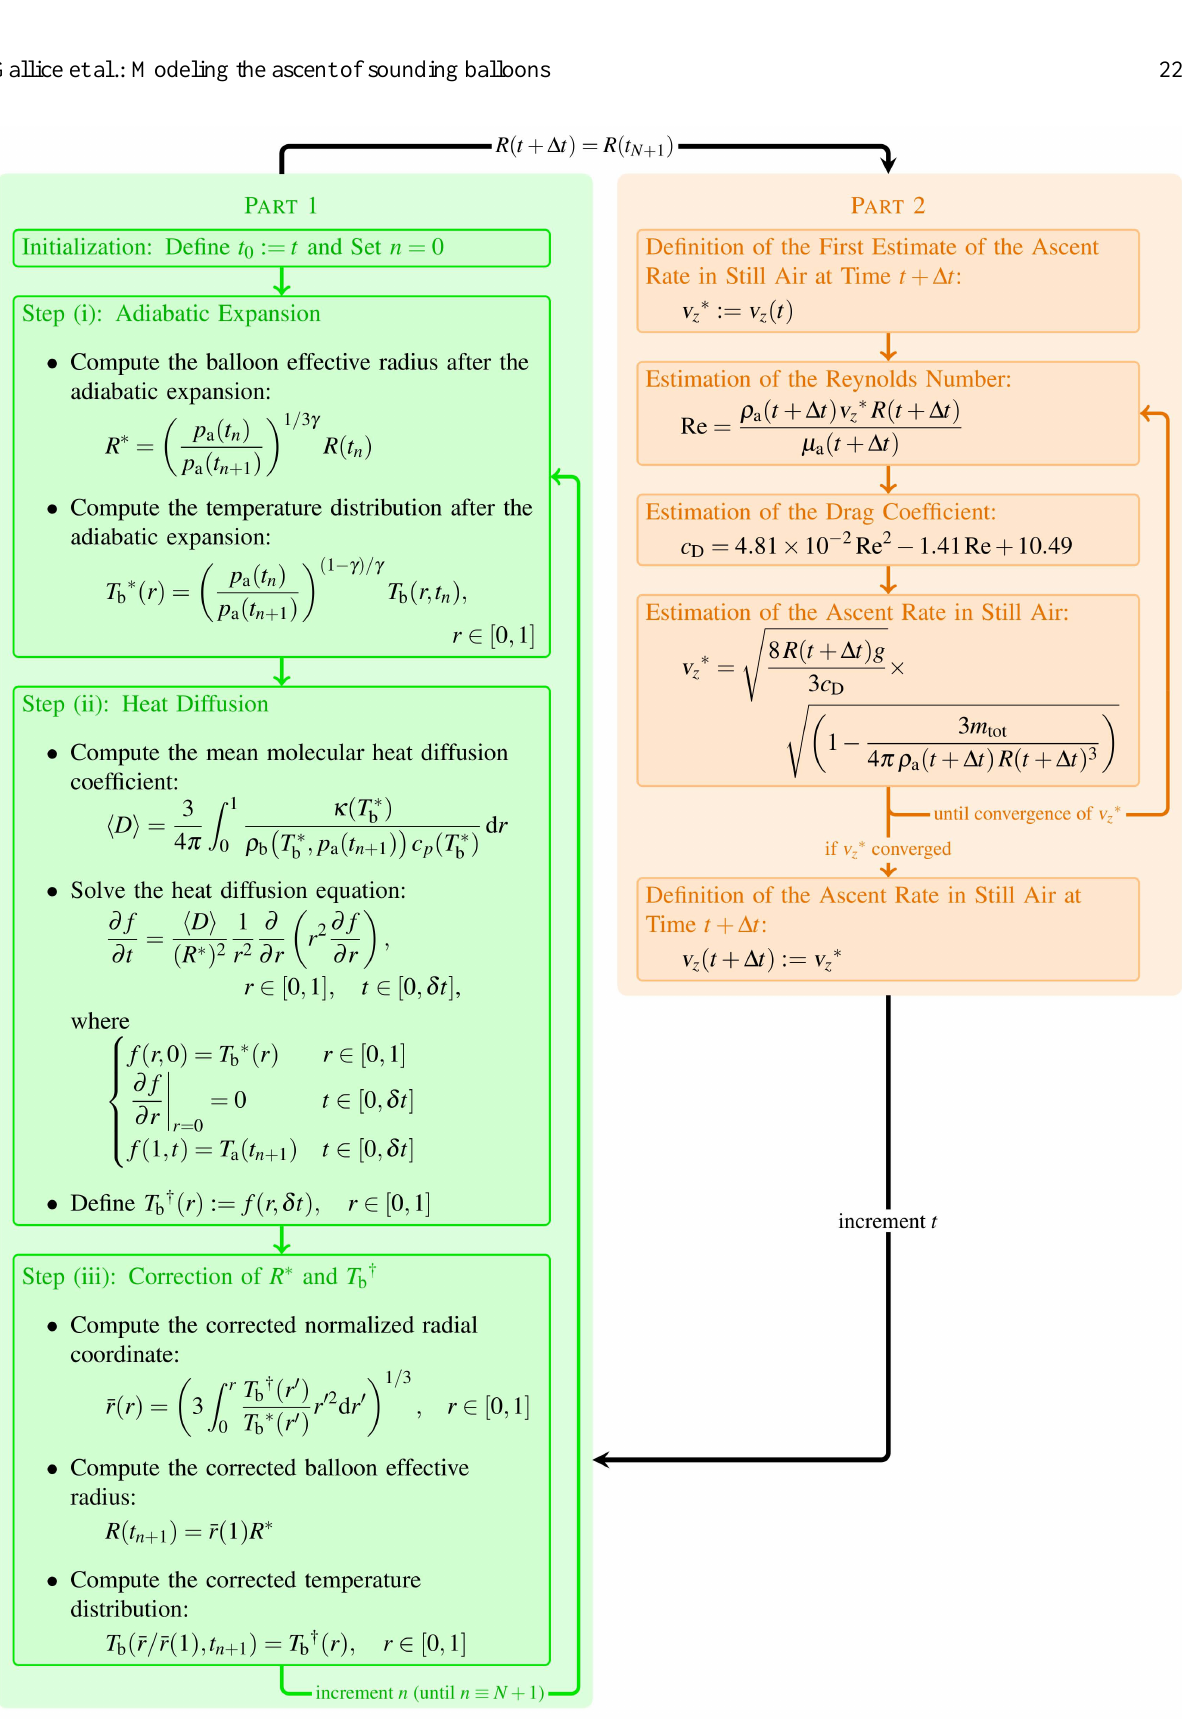
Fig. 4. Schematic representation of the different steps of the model. The notation is introduced in Sect. 3.